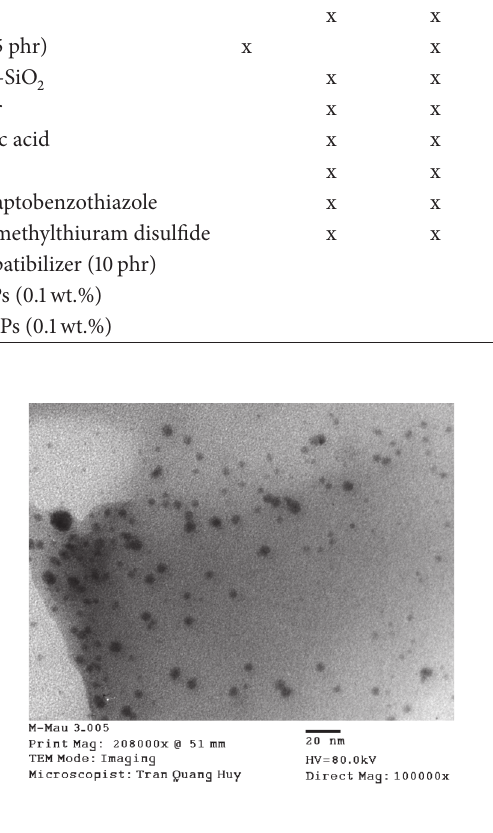
Figure 1: TEM image of AgNPs dispersed in PE matrix (at 2wt.%).